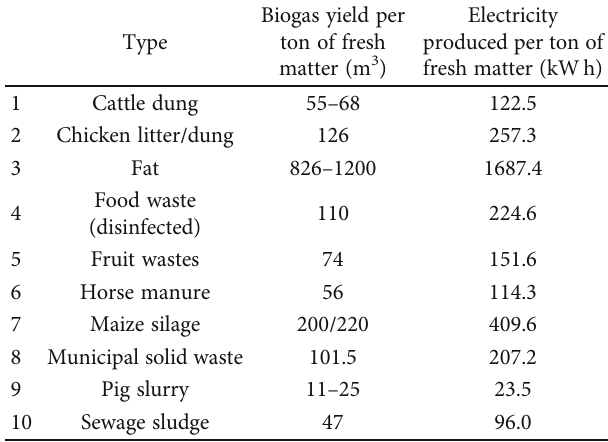
Table 4: Comparison of biogas yield and electricity produced from di ff erent potential substrates [7,